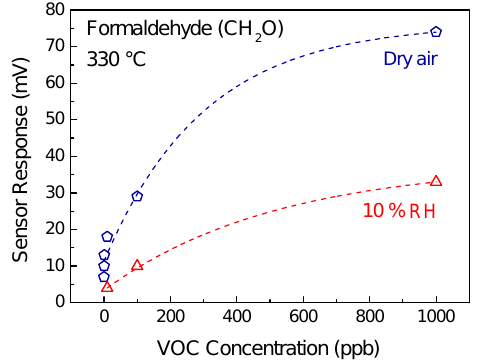
Figure 6. Sensor response to different concentrations of naphtha- lene (C 10 H 8 ) from 10 to 0.5ppb at 330 ◦ C, and 20% relative hu- midity (RH). The sensor signal (not filtered in the figure) has very low electronic noise and shows superb sensitivity to naphthalene in the sub-ppb range.